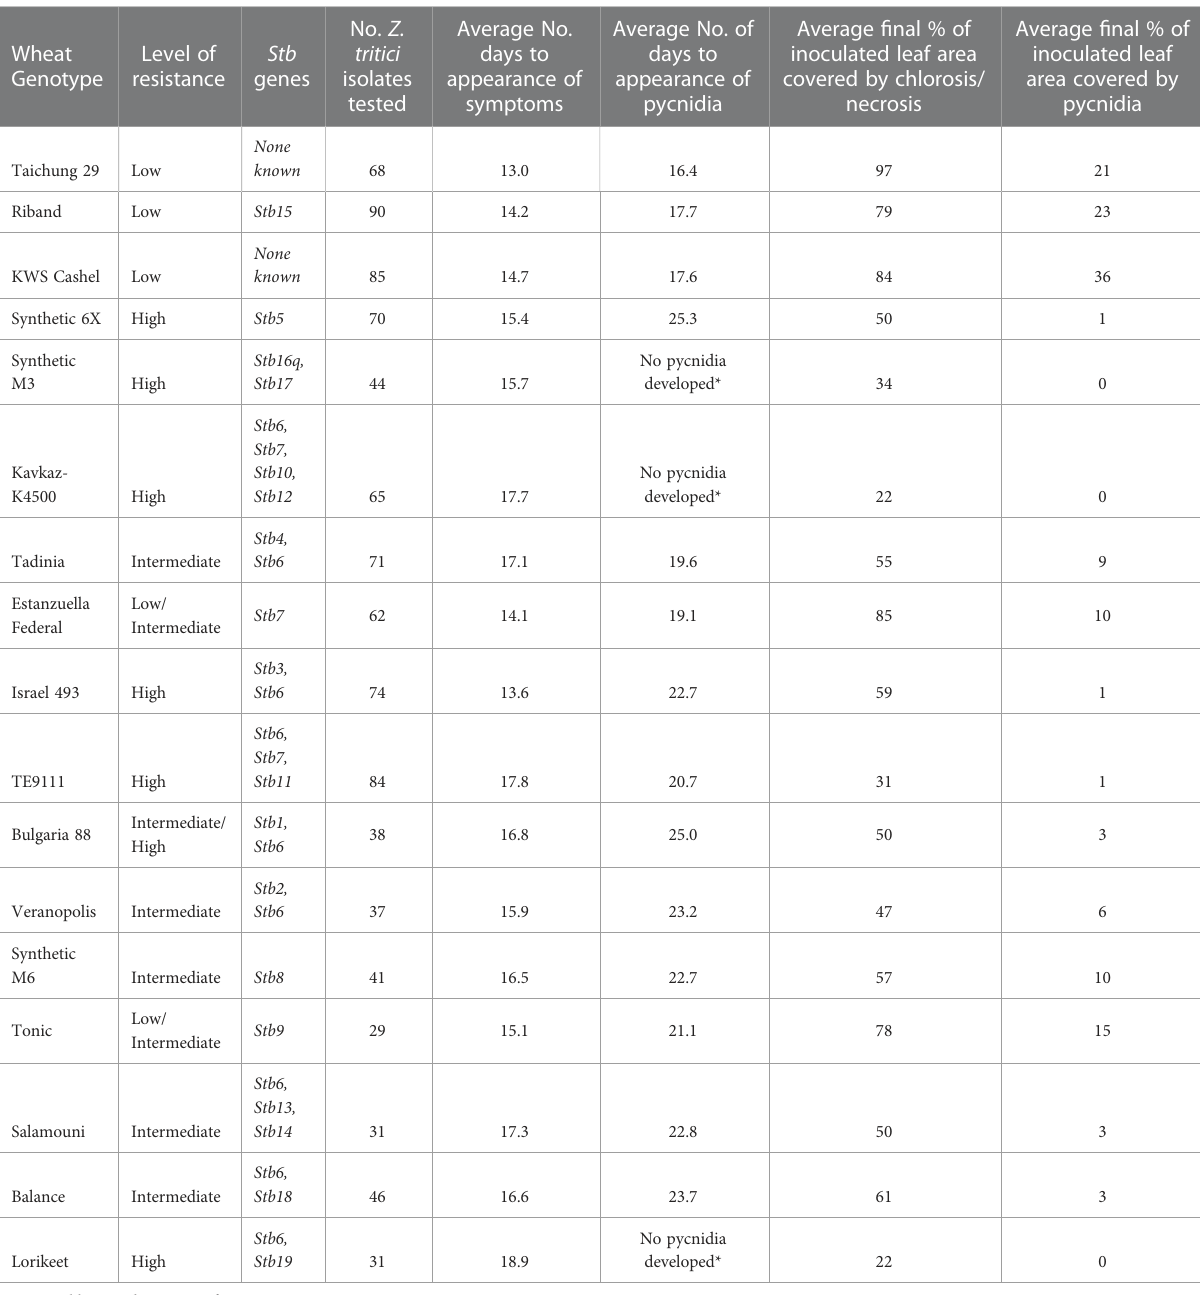
TABLE 3 The average symptoms on inoculated leaves of each wheat genotype.